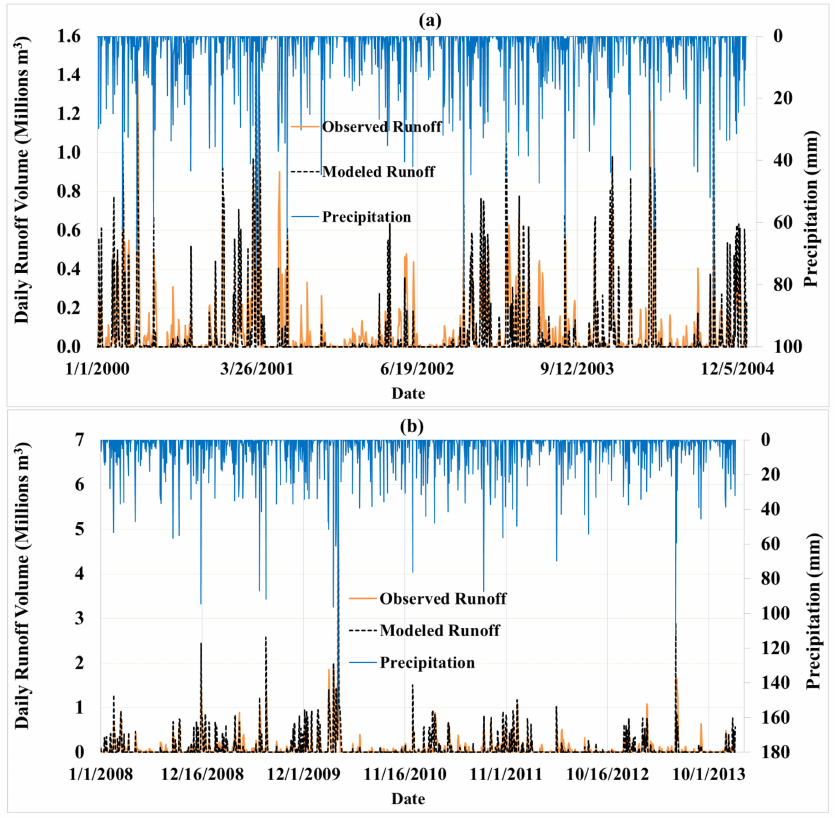
Figure 4. Graphical comparison between daily modeled and observed runo ff ( a ) after calibration and ( b ) validation phase for Pawcatuck River Watershed. Table 6. Runo ff calibration and validation results for Pawcatuck River watershed.